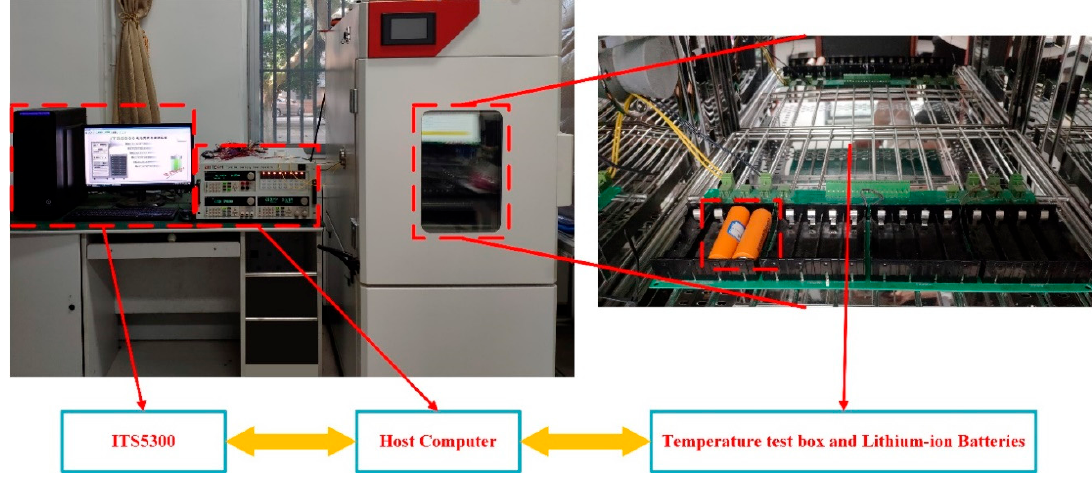
Figure 7. Test bench.